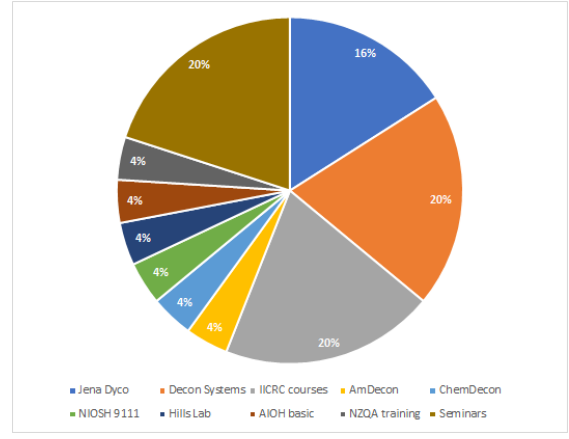
Figure 1. The reported testing and remediation qualifications.